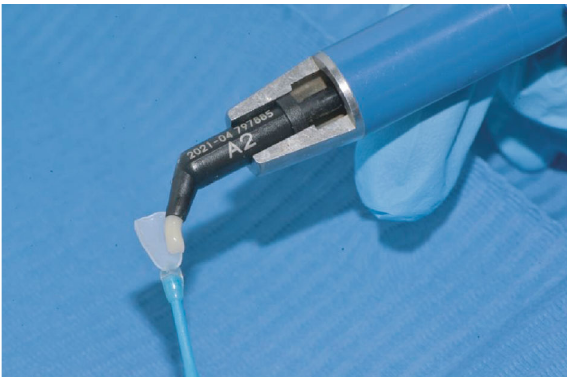
Figure 11: Veneer loaded with the selected composite